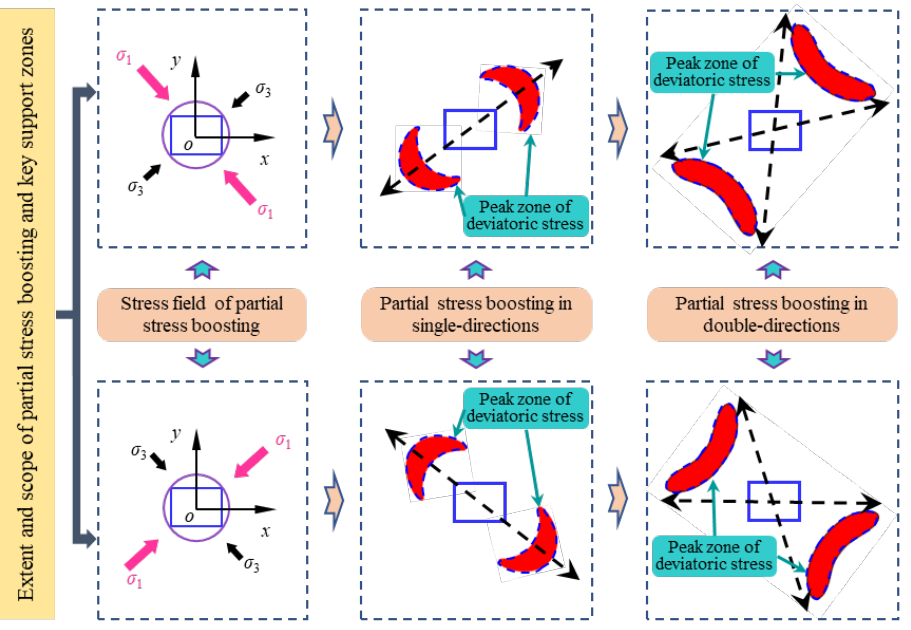
Figure 7. Evolutionary pattern of surrounding rock damage under different stress direction deflection and partial-stress boosting conditions.